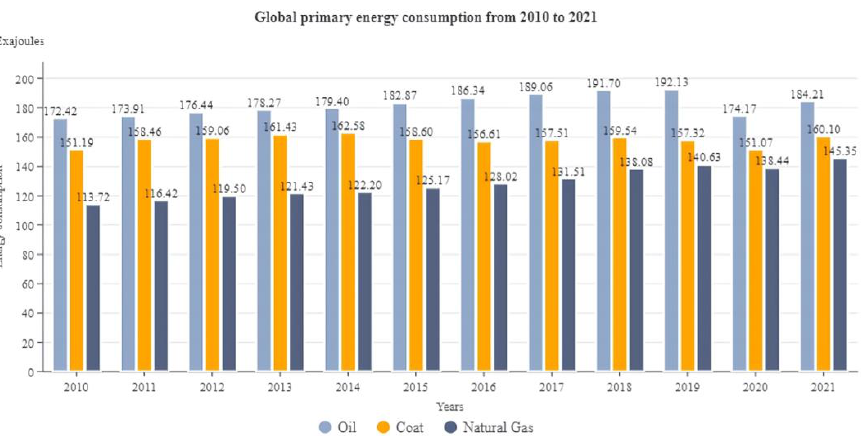
Figure 1. LNG imports from 2000 to 2021.